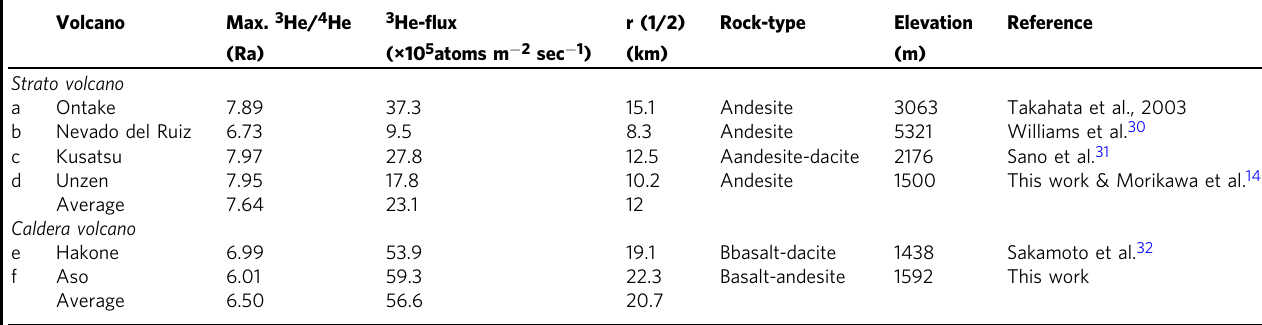
Table 1 Summary of helium isotope variations around volcanoes. Volcano